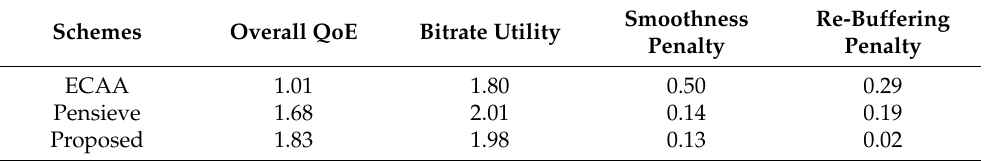
Table 2. Summary for the overall QoE and the individual QoE components.